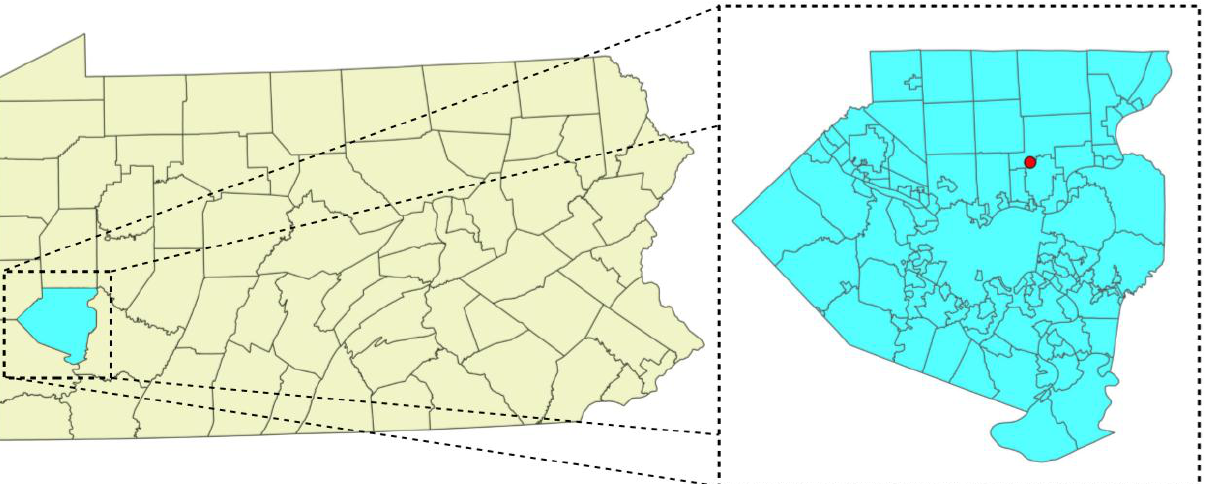
Figure 2. Location of the Audubon Society of Western Pennsylvania (ASWP) testbed (red dot) in Allegheny County (highlighted in cyan and enlarged), Pennsylvania,